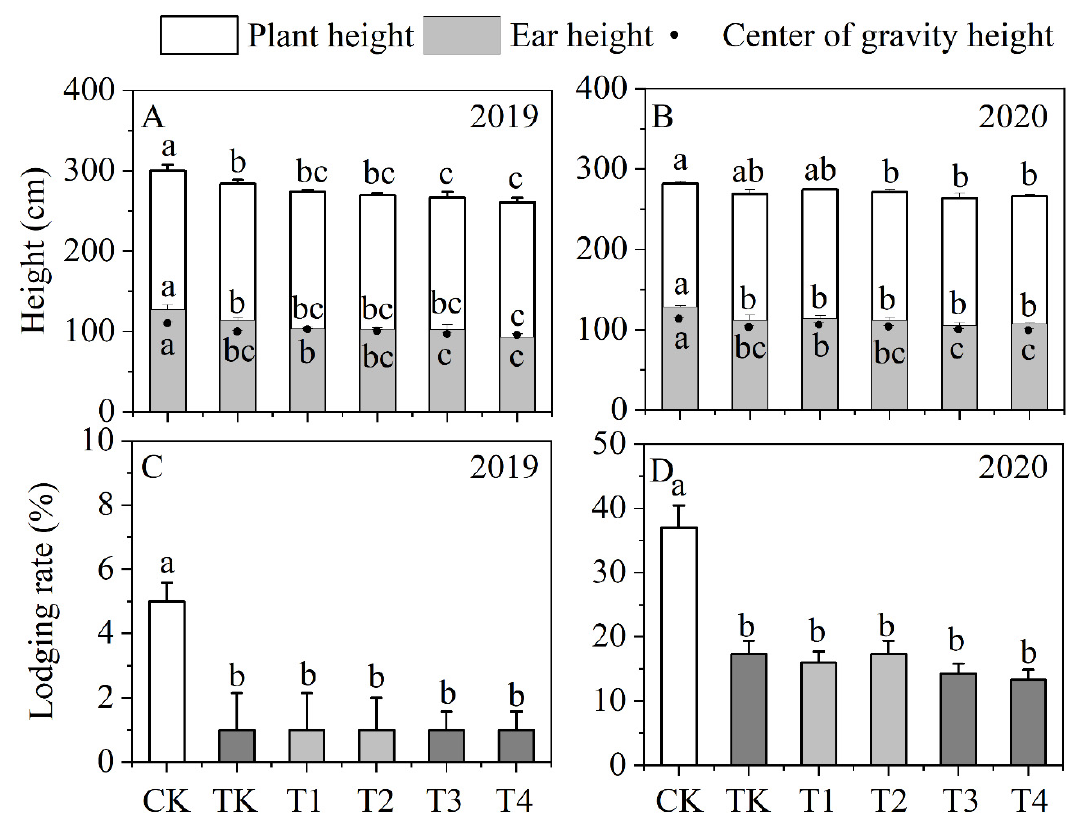
Figure 6. The plant, ear, center of gravity height, and lodging rate in 2019 and 2020. The plant height, ear height, and center of gravity height in 2019 ( A ) and 2020 ( B ). The lodging rate in 2019 ( C ) and 2020 ( D ). One-way ANOVA followed by Tukey test was used, and different letters above the bars indicated the significant differences ( p < 0.05) among treatments. Bars are the standard deviation of three replications. Table 2. The results of significance analysis of spray volume and EDAH dosage on plant indicators for UAV treatments in 2019 and